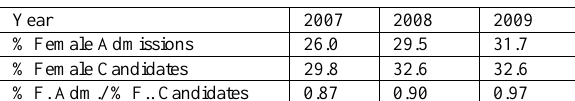
TABLE V. S TATISTICS OF FEMALE PERFORMANCE IN THE 1 ST PHASE OF APPLICATION OF 1 ST YEAR STUDENTS TO